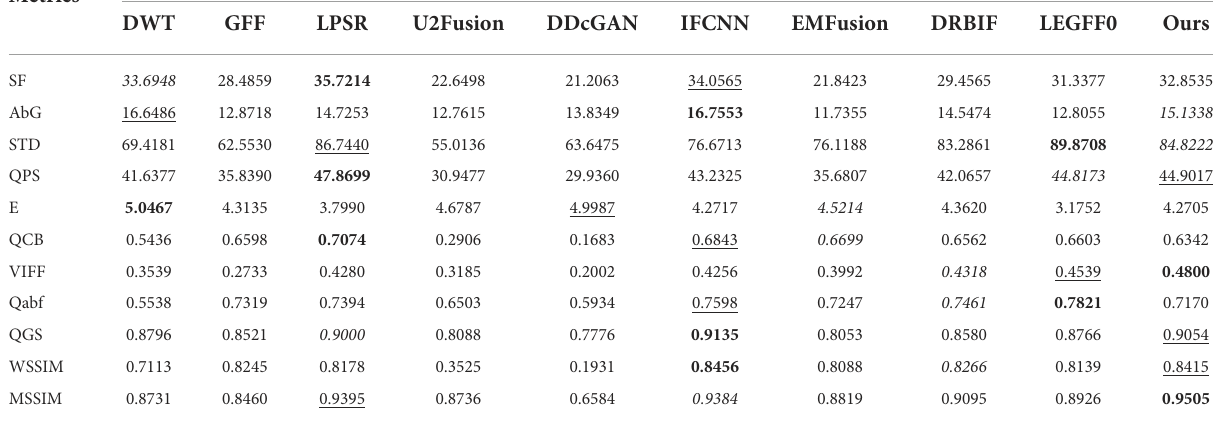
TABLE 1 Quantitative evaluation results on the CT-MRI dataset.